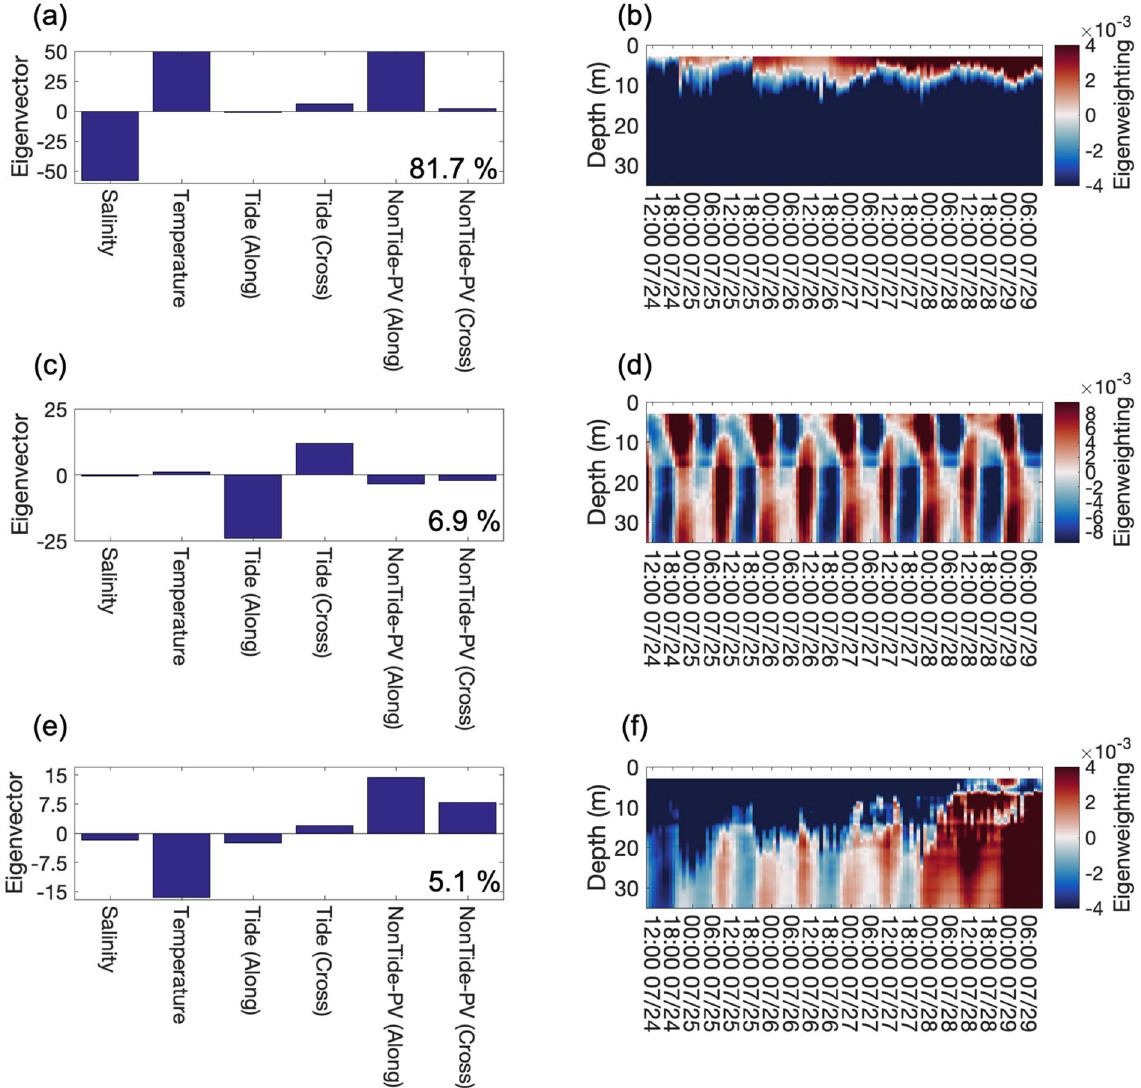
Figure 6. The eigenvectors and contoured eigenweightings of each eigenmode. ( a ) and ( b ) show the eigenvectors and contoured eigenweightings of 1st eigenmode. The positive contoured eigenweightings indicate the co-variability shown in the eigenvector. The negative eigenweightings indicate the inversed correlations shown in the eigenvector. ( c ) and ( d ) show the eigenvectors and contoured eigenweightings of 2nd eigenmode. ( e ) and ( f ) show the eigenvectors and contoured eigenweightings of 3rd non-tidal current is regarded as wind-driven (Fig. 2, Supplementary Fig. 5), this mode demonstrates the cold- water intrusion related to the wind, which leads to upwelling near the coast 37,42,43 . The contour plot of eigen- weightings indicates the thickening of the cold water in the lower column that gradually extended upward into shallower depths (the red patch in Fig. 6f). Ultimately, the intrusion reached 20 m above bed. The eigenweightings also depict that the water temperature fluctuated at semi-diurnal frequencies between 06:00 July 25 and 12:00 July 27, which corresponded to the across-shore tidal currents (Figs. 3c,6f). The EOF analysis clearly established a hierarchy in the process-response pattern at a fixed point on the pathway of the Pearl River plume. Firstly, as the fresher and warmer Pearl River effluent exited the PRE, the typical southwesterly summer monsoon and northeastward wind-induced current were the primary forcing to cause the river plume to disperse northeastward and seaward (Supplementary Figs. 1 and 2). Then, the Pearl River effluent is propagating along the Guangdong coast and enters the Taiwan Strait 36,42,57 . On this setting, the presence of the buoyant river plume caused strong stratification in the upper part of the water column along the river plume dispersal pathway (between 5 and 10 m depth defined by EOF; Figs. 3b–d, 4b, 6a,b). The stratifica- tion created a density barrier against water exchange between river plume water and ambient seawater beneath (Fig. 4). Above the stratified layer, the mixing was induced by wind because the low S p indicates the prevailing wind-mixed environment. The wind induced mixing could disrupt the in-situ stratification occasionally when the water density gradient was low 21,27 (marked as the red bar in Fig. 4b).